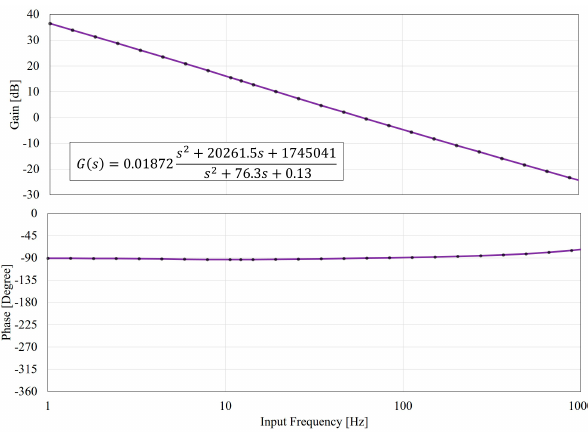
Figure 8. The Bode plots based on the proposed model in Equation (6) and the curve fitting on the gain response. Both the gain and the phase match well to the experimental analysis in Figure 7. The spectrum is further extended to 1000 Hz for the prediction of the system response at higher frequencies.